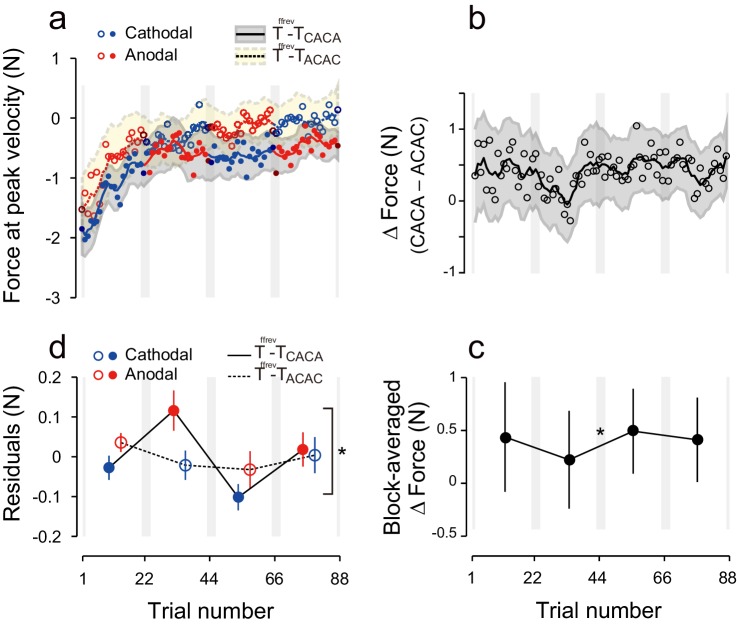
Polarity-dependent changes in the aftereffect for the Tffrev-T groups.The format is identical to Figures 2 and 3. *p<0.05.